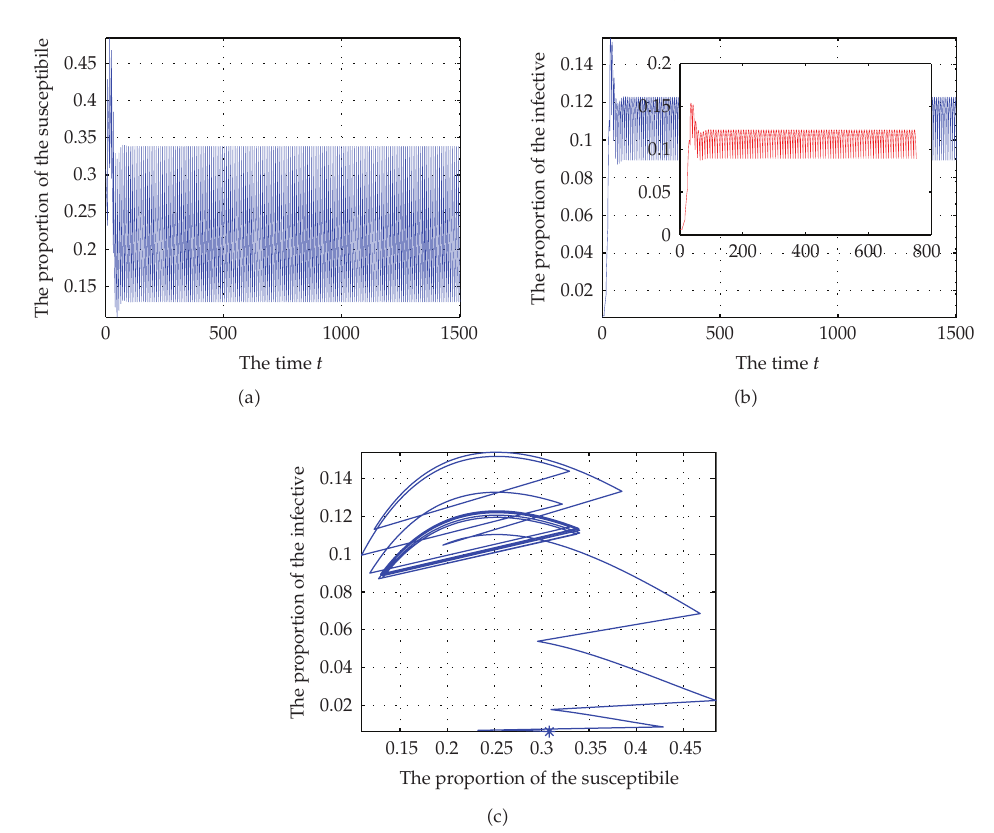
Figure 2: The time series and the orbits of the system (cid:5) 2.4 (cid:6) with R ∗ > 1. (cid:5) a (cid:6) and (cid:5) b (cid:6) show the time series for susceptible and infective, respectively. (cid:5) c (cid:6) shows the orbits s − i plane. and the comparison principle implies that i (cid:5) t (cid:6) ≥ η exp {− (cid:5) θ (cid:8) α (cid:6)(cid:5) t − t 1 (cid:6) } ≥ η exp {− (cid:5) θ (cid:8) α (cid:6) T ∗ }